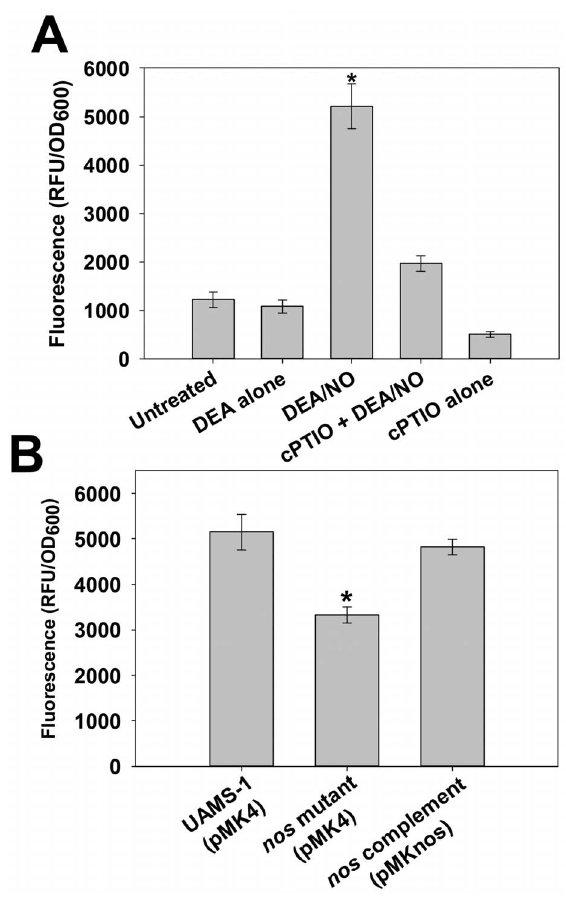
Figure 7. Detection of intracellular NO/RNS with DAF-FM diacetate. A: Cells harvested from replicate UAMS-1 7 hour static biofilms were resuspended in HBSS containing 5 m M DAF-FM diacetate. After incubation for 1 hour at 37 u C, cells were collected by centrifugation, washed, and resuspended in HBSS alone (‘‘untreated’’) or HBSS supplemented with 100 m M DEA or 100 m M DEA/NO. Where indicated, 150 m M cPTIO (NO scavenger) was added to cell suspensions during the 1 hour DAF-FM diacetate staining step. Aliquots (200 m l) of each cell suspension were immediately transferred to a 96-well plate, and incubated at 37 u C in a Synergy HT fluorescent plate reader. Fluorescence and OD 600 measurements were recorded after 30 min- utes, and data were reported as relative fluorescent units (RFU) per OD 600 of each well. Data represents the average of n=3 independent experiments, error bars = SEM. *statistical significance compared to untreated UAMS-1 (p , 0.05, Tukey Test). B: UAMS-1 (pMK4; wild-type), KR1010 (pMK4; nos mutant), and KR1010 (pMKnos; nos complement) were grown on agar plates for 26 hours, followed by harvesting and resuspension in HBSS + 5 m M DAF-FM dicaetate. Fluorescence (RFU) and OD 600 readings were recorded after 90 minutes incubation in a microplate reader as described above. Data represents the average